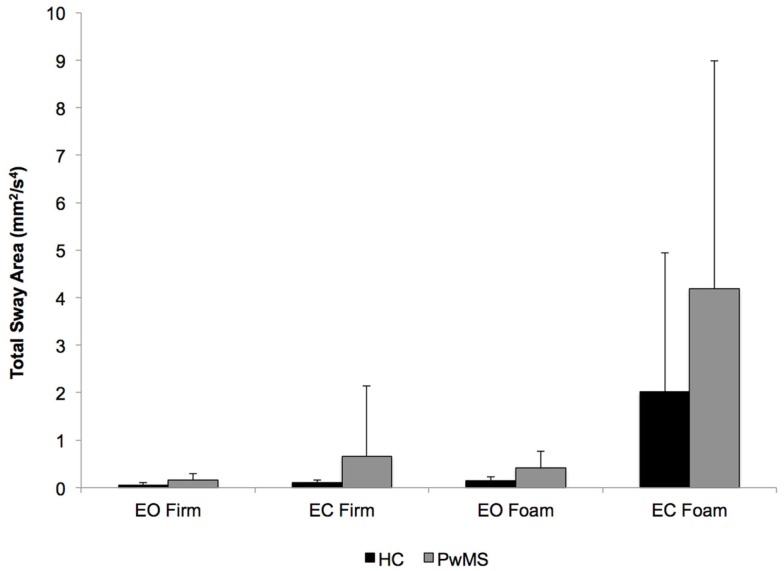
Total sway area for each of the four conditions tested with the ICTSIB. A significant main effect of group (P < 0.05), but lack of a group × condition interaction, is reflective of PwMS having greater sway area for all conditions compared to HC. Data are mean (± SD).